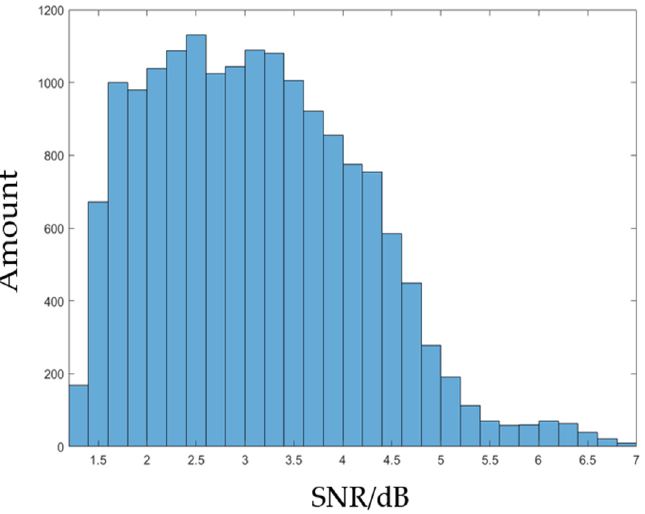
Figure 14. The number distribution of SNR with wind speeds between 9 and 12 m/s.